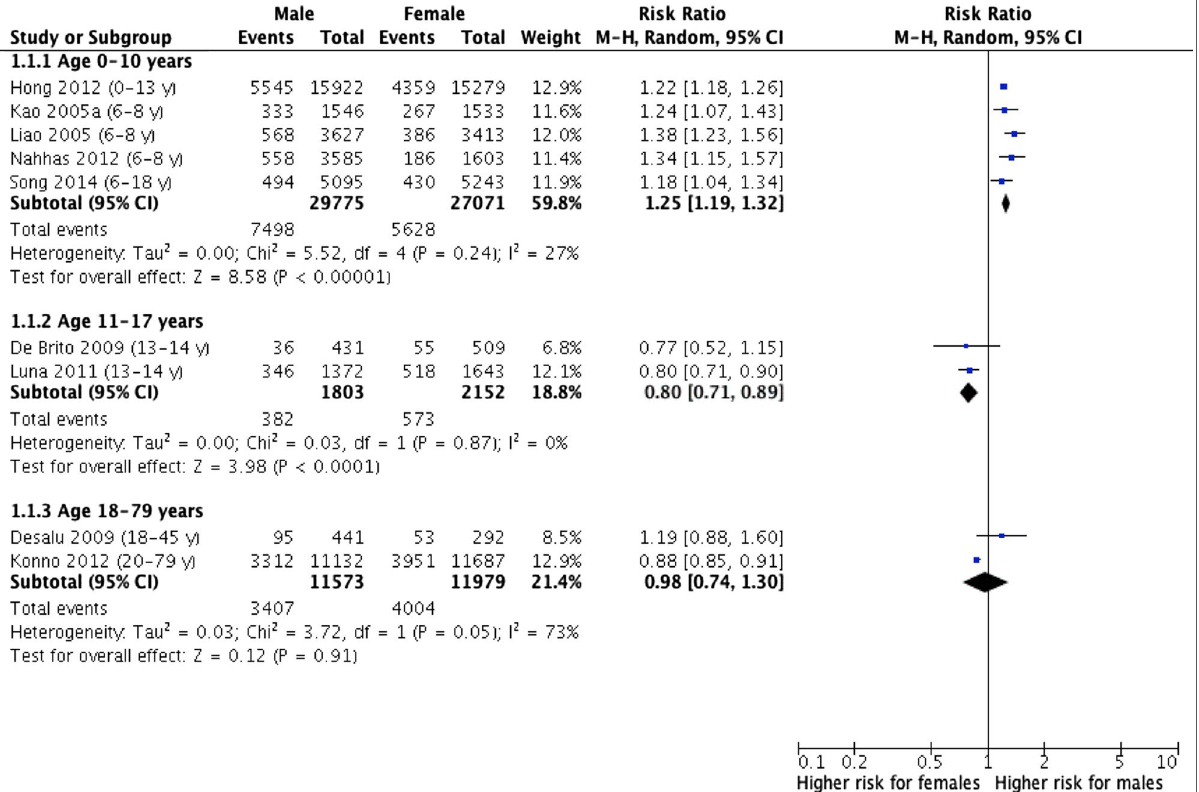
Fig. 3 Forest plot estimating the difference in prevalence of allergic rhinitis only between males and females in childhood, adolescence and adult-